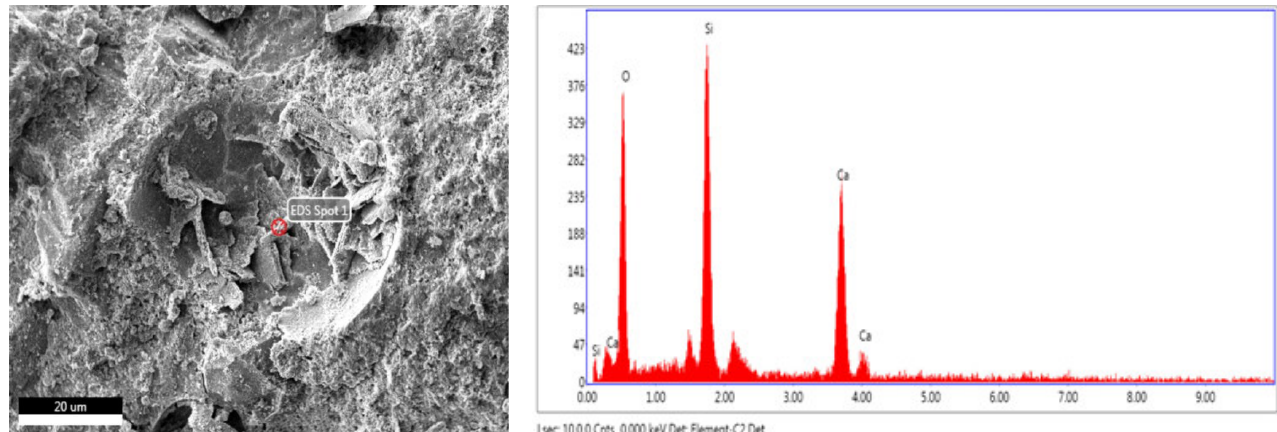
Figure 6. SEM images and EDX analysis of synthetic wollastonite.